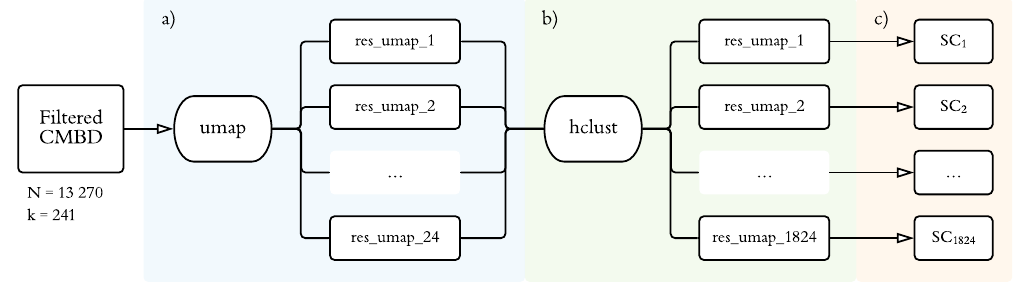
Figure 2. Statistical procedure. ( a ) Application of 24 combinations of uniform manifold approximation and projection (UMAP), varying the number of dimensions (2–5), minimum embedding distance (0.1, 0.5), and number of neighbors (15, 50, 100). ( b ) Application of agglomerative hierarchical clustering for each of the 1824 combinations changing the clustering method (average, centroid, Ward, and complete) and number of clusters selected (2–20). ( c ) Average silhouette coefficent for each computed